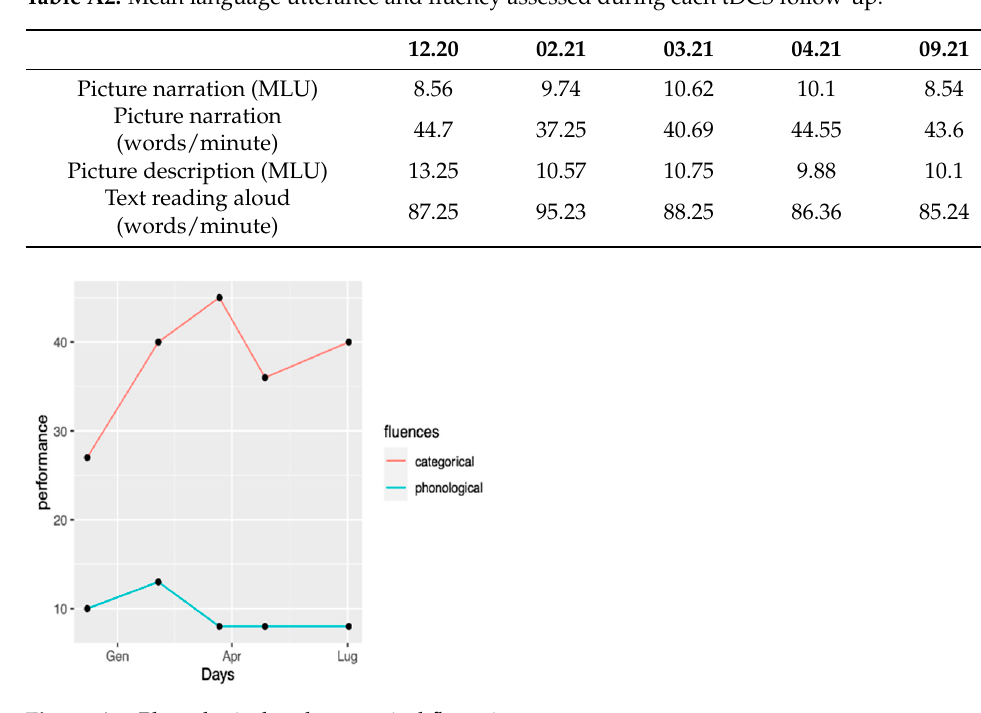
Figure A1. Phonological and categorical fluencies.